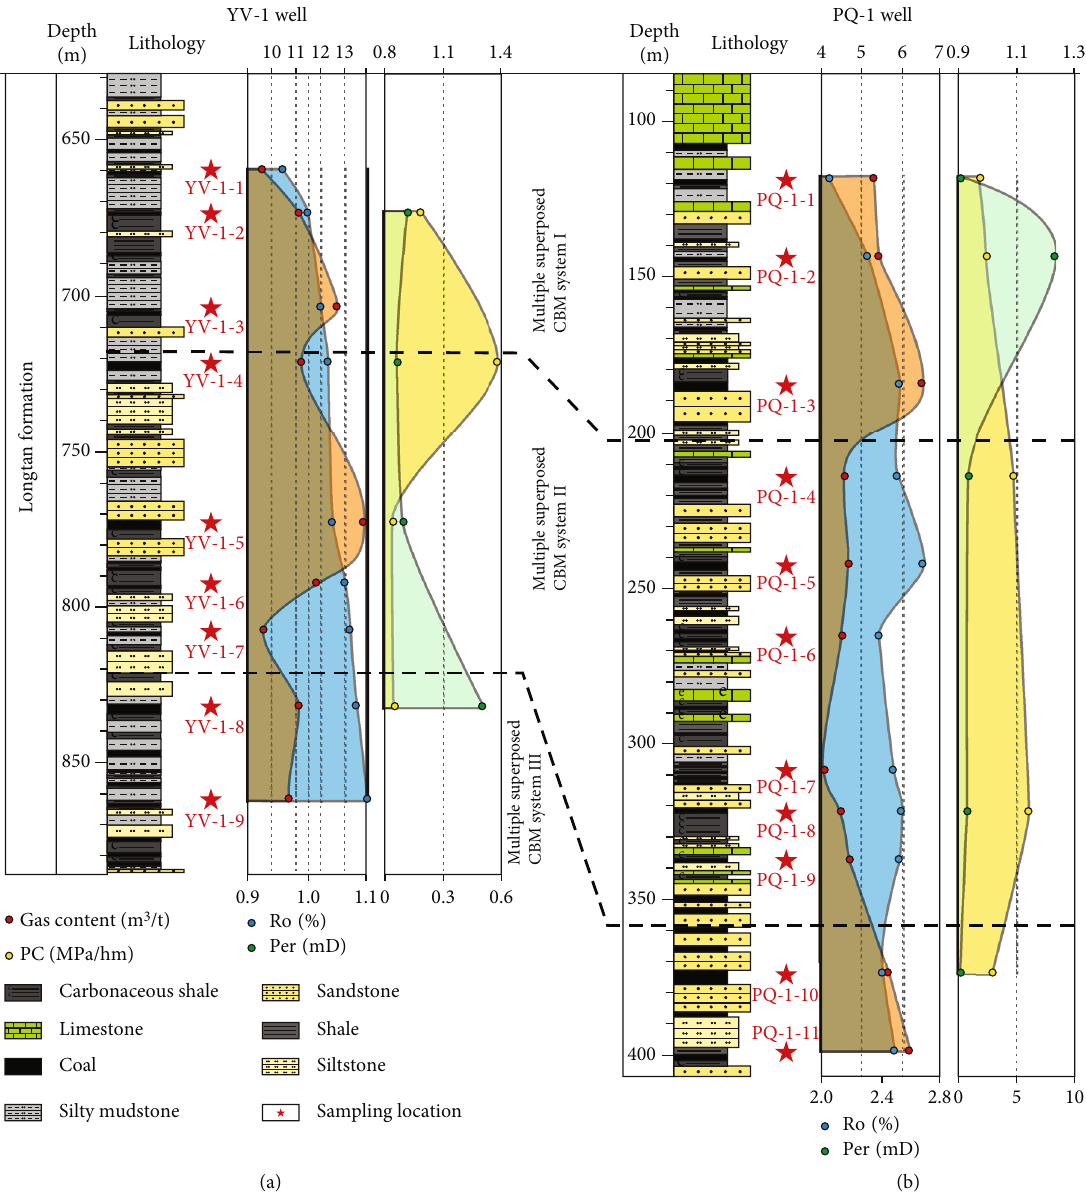
Figure 3: Sampling locations of wells PV-1 and PQ-1, showing the gas content, Ro, pressure coe ffi cient, and permeability of samples. The division of multiple superposed CBM system was modi fi ed from